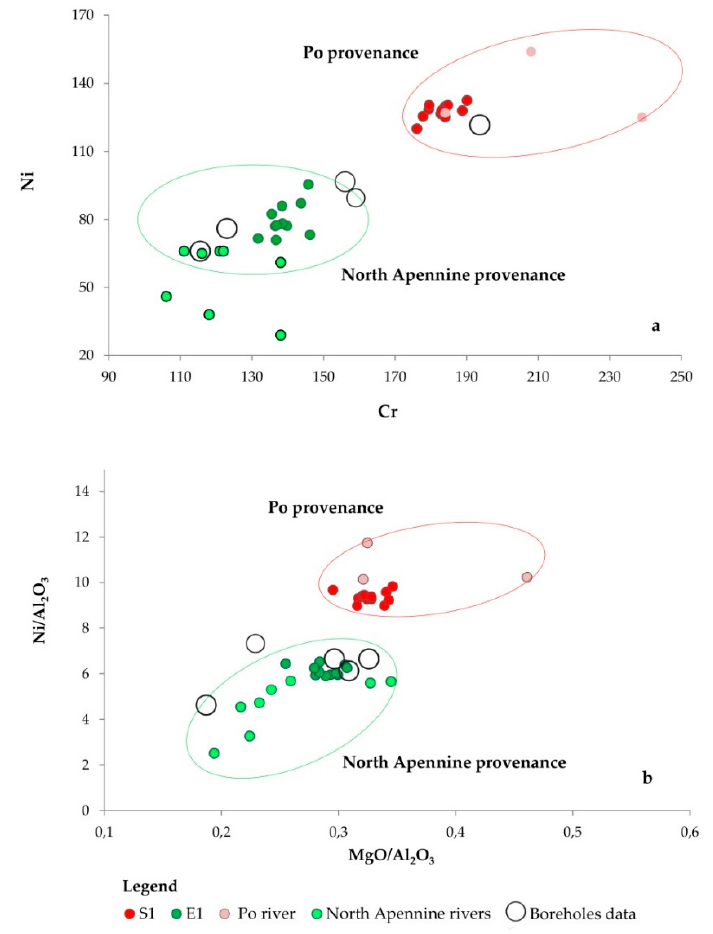
Figure 6. ( a ) Binary plots of Ni vs. Cr and ( b ) Ni / Al2O3 vs. MgO / Al2O3 ratios. Our samples are indicated as green and red dots. Reference data for rivers (light green, Apennines; light red, Po River) derive from tables presented in [30]. Reference data for boreholes (empty big circles) represent the average values presented in [27]. Provenances fields (green and red circles) are drawn in accordance with literature data